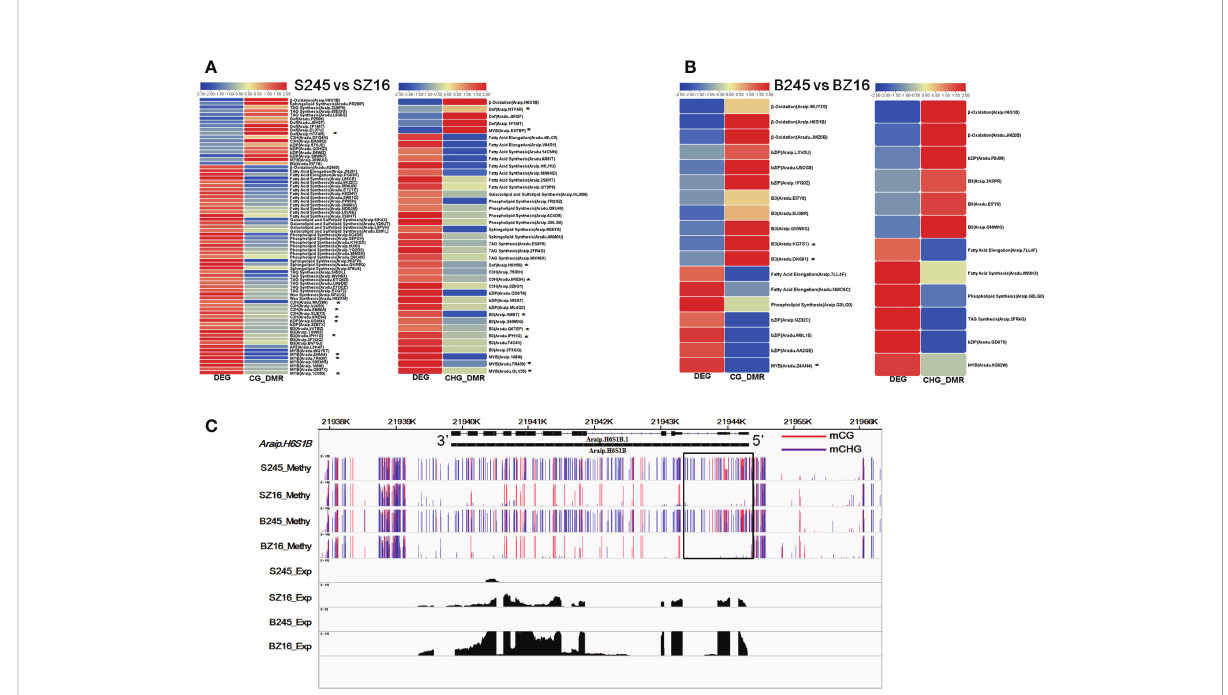
FIGURE 7 CG-DMR or CHG-DMR and their association with the expression of lipid metabolism-related genes. (A, B) Heatmaps showing CG-DMR and CHG-DMR between 245 and Z16 associated with differential expression at the R5 (A) and R8 (B) stages for sets of enzymes and TFs involved in lipid metabolism, respectively. * denote the CG-DMR- or CHG-DMR-associated TFs which were identi fi ed to co-express with lipid metabolic DEGs. Scales represent differential expression and differential methylation in log2 fold change. CG-DMR and CHG-DMR indicated differentially methylated regions in CG and CHG context, respectively. (C) A visualization showing the methylation level and expression level of acyl transporter ( Araip.H6S1B ) in seeds of 245 and Z16 at the R5 and R8 stages. S245 and SZ16 represented seeds of 245 and Z16 at the R5 stage, respectively. B245 and BZ16 denoted seeds of 245 and Z16 at the R8 stage,